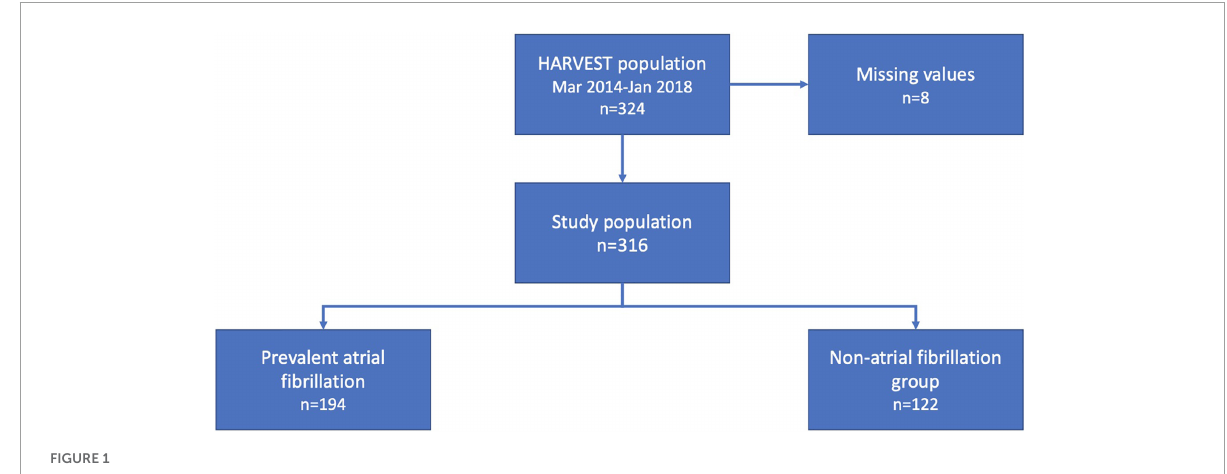
FIGURE1 Flowchart of the study